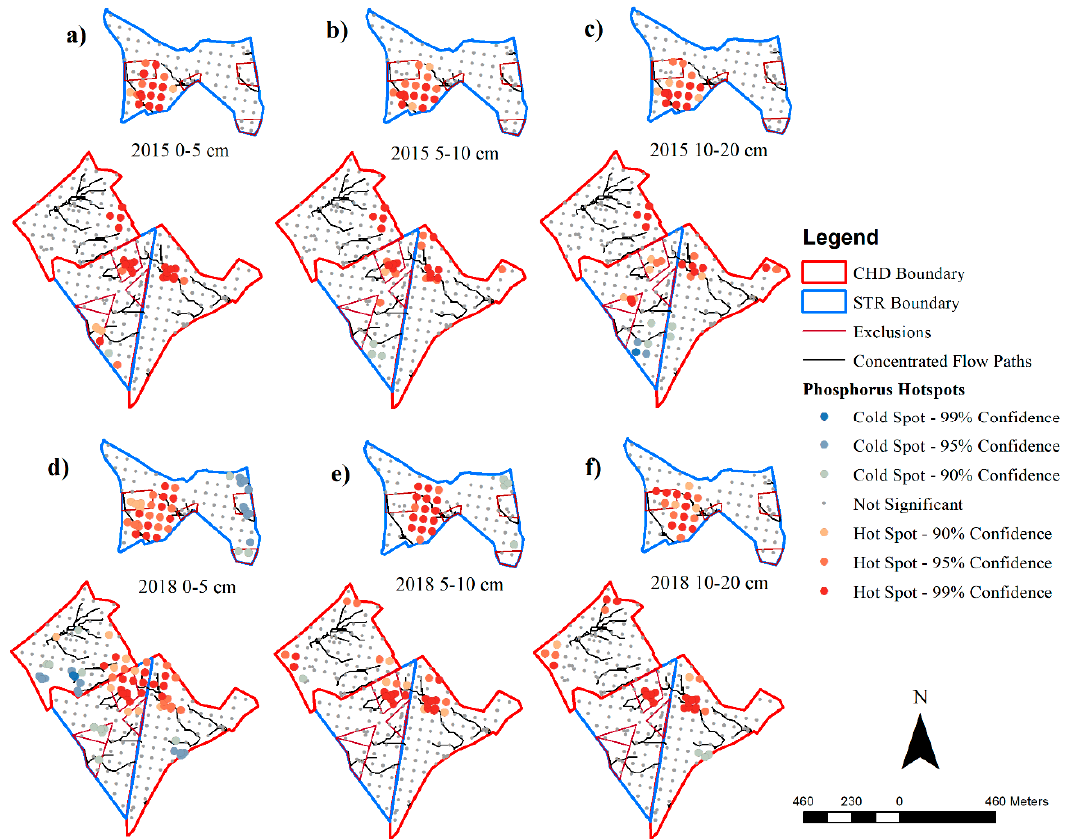
Figure 2. Hotspots of Mehlich-1 phosphorus (M1P) concentrations at 0–5, 5–10, and 10–20 cm soil depths during Baseline sampling (2015; ( a – c )) and Post-Treatment (2018; ( d – f )) at the Eatonton pastures. Change in M1P distribution was mapped for the Eatonton (Figure S1) and the